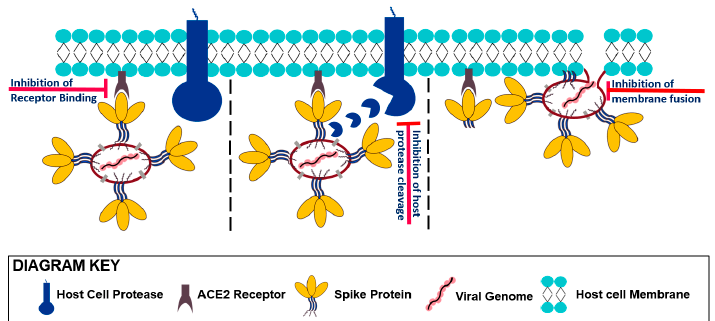
Figure 2. Entry mechanism of Sars-CoV-2 into human host cells. SARS-CoV-2 enters host cell by attaching its surface-anchored spike protein to the cell surface receptor ACE2. Such attachment activates various host cell proteases and causes them to cleave the spike protein at a site near the S1 / S2 boundary. Cleavage of the spike protein, in turn, facilitates viral fusion and subsequent insertion of the viral genome into the host cell. Sites of inhibition by small molecules, namely the site of receptor binding, the site of host protein cleavage and the site of membrane fusion, are marked at each stage of viral entry. The schematic is not drawn to scale. Enlargement has been employed to better depict the viral entry mechanism.